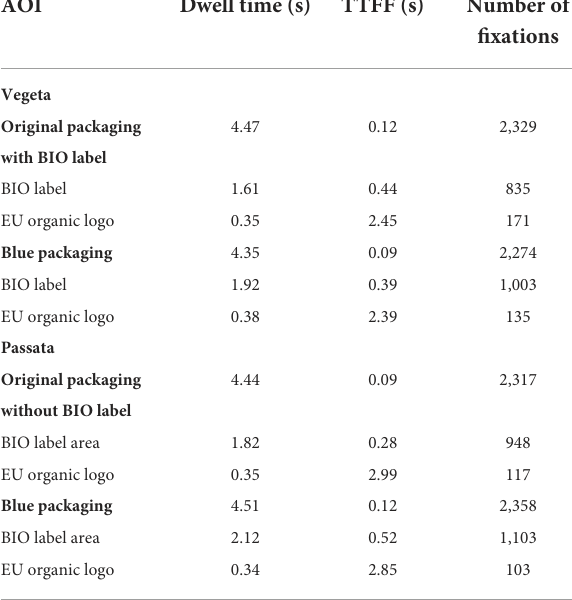
TABLE 2 Eye-tracking metrics assessing visual attention during bio-label manipulation for both products. AOI Dwell time (s) fixations